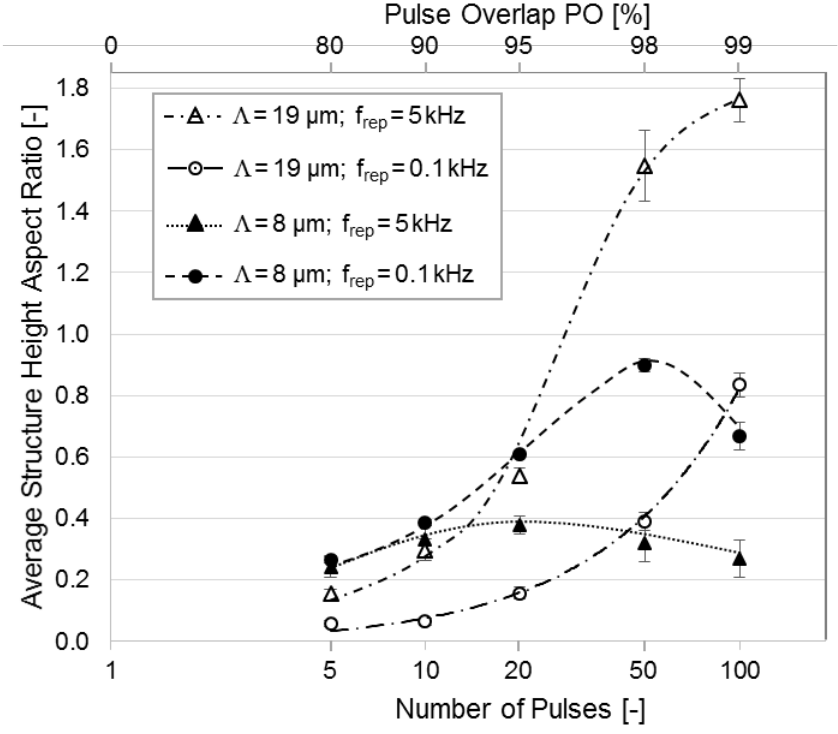
Figure 5. Average structure height aspect ratios for patterns with period Λ = 19.0 µm and Λ = 8.0 µm for different pulse repetition rates (f rep of 0.1 and 5 kHz) depending on the pulse overlap. The applied laser fluence was 3.2 J∙cm −2 . Dotted lines are only to guide the eyes; no uniform regression was